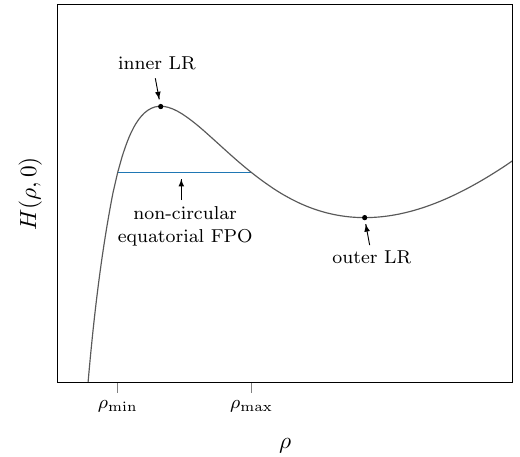
Fig. 1 General form of the effective potential H (ρ, 0 ) when L < M /ϕ . The stationary points correspond to LRs. The blue line corre- sponds to a non-circular equatorial FPO